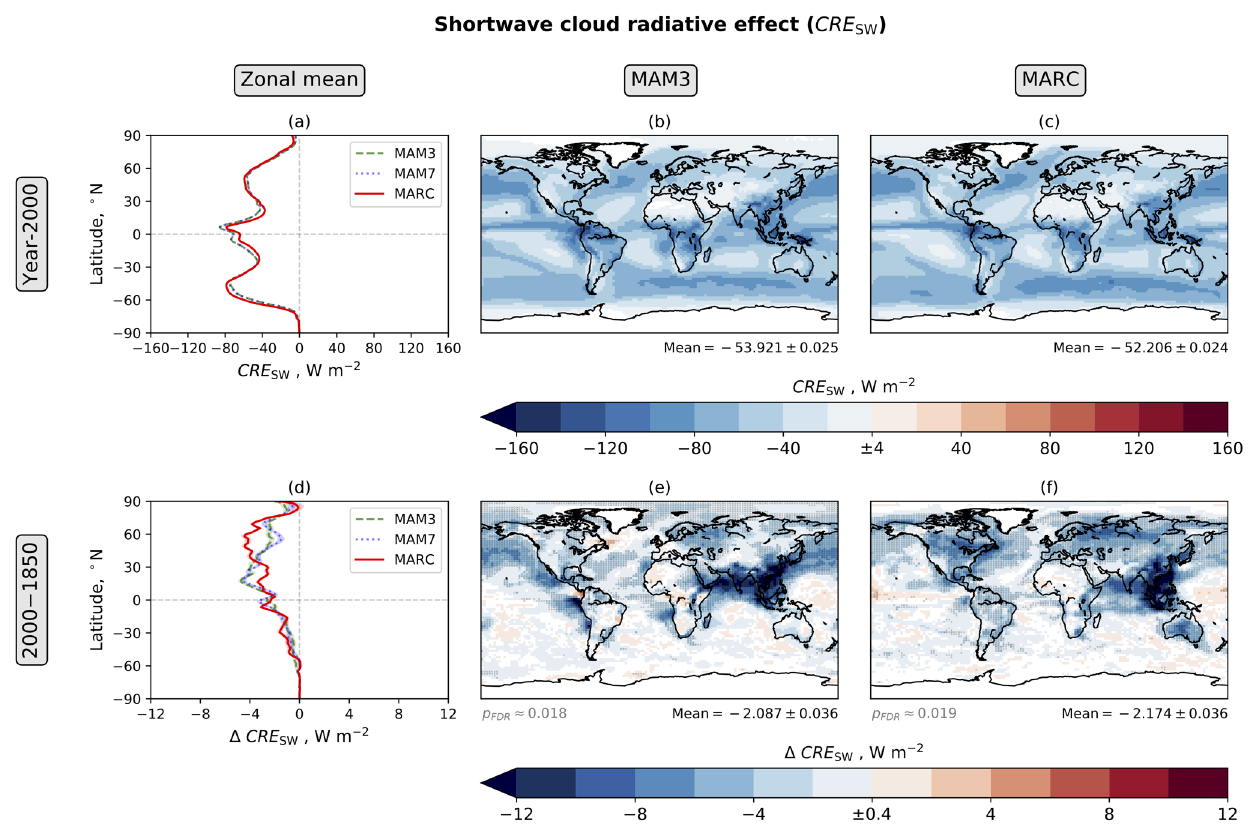
Figure 14. Annual mean clean-sky shortwave cloud radiative effect (CRE SW ; Eq. 4). The figure components are explained in the Fig. 2 caption. For all four maps, white indicates differences with a magnitude less than the threshold value in the centre of the corresponding colour